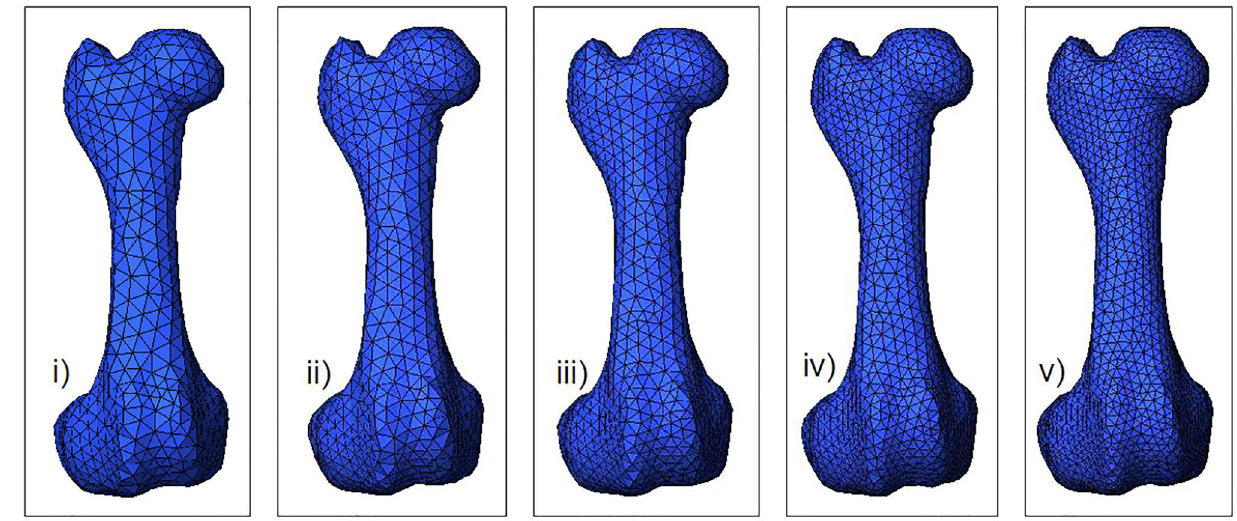
Fig. 3 Details of the finite element mesh for the five different